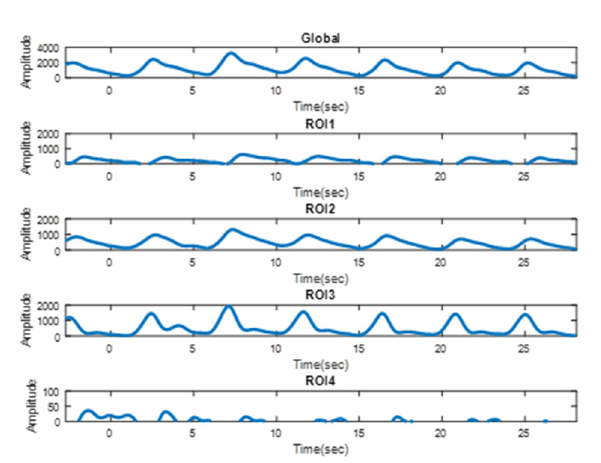
Fig. 2. Electrical Impedance Tomography of lung’s four